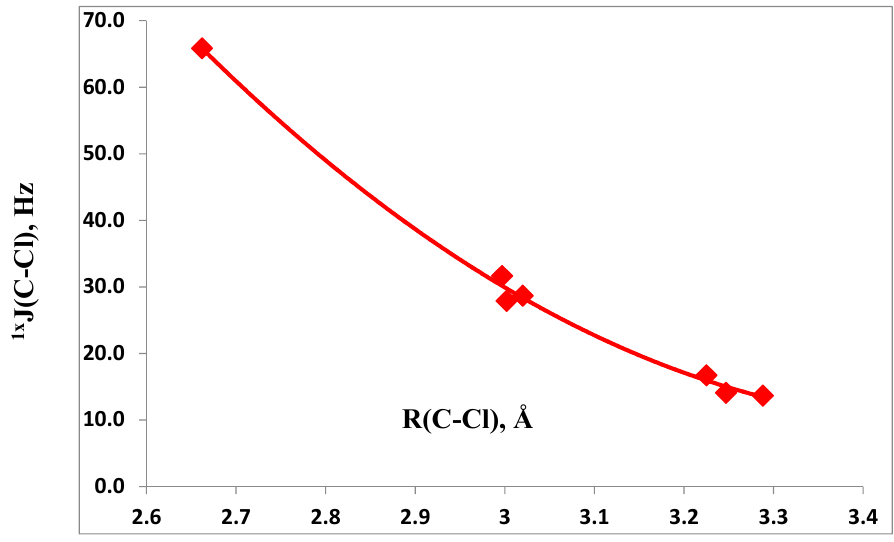
Figure 4. 1x J(C–Cl) versus the C–Cl distance for OC:ClY complexes.